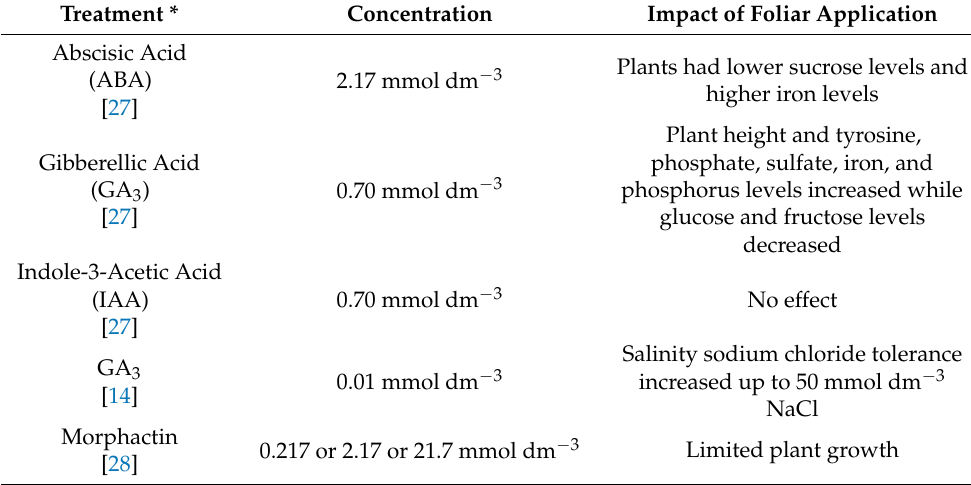
Table 4. Impact of foliar application of growth regulators on pepper. Treatment